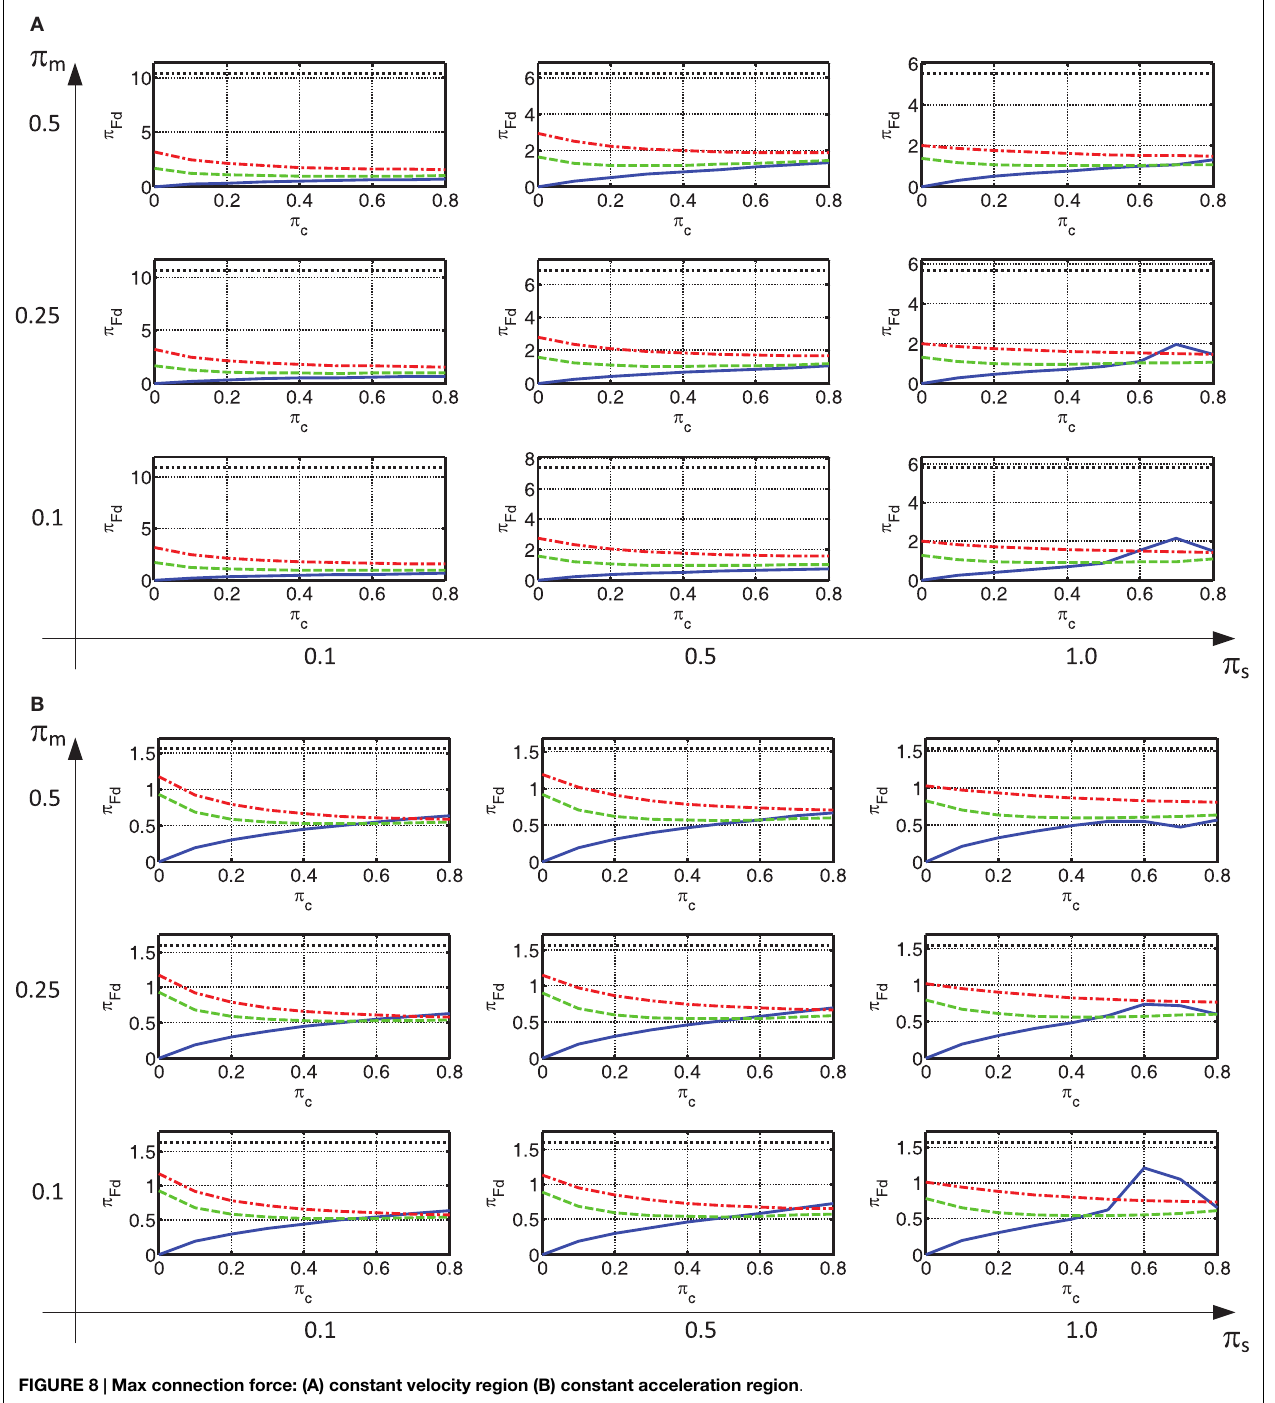
FIGURE 8 | Max connection force: (A) constant velocity region (B) constant acceleration region .